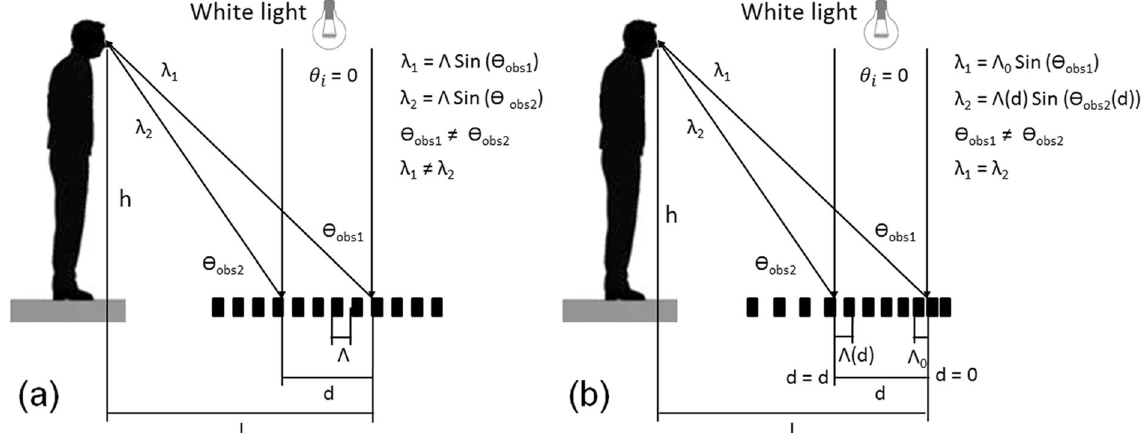
Figure 1. Schematic representation of diffraction of white light by a surface containing ( a ) a periodic structure with a constant spatial period Λ and ( b ) a gradient periodic surface structure with a variable period following Eqs 3 to